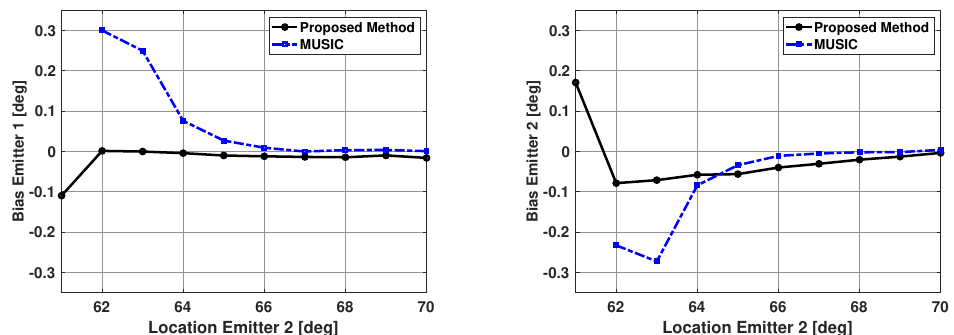
Figure 10. Biases in the estimated direction of the two emitters versus angular separation: Proposed Method and the MUSIC Algorithm, SNR = 5 dB, 100 snapshots, 500